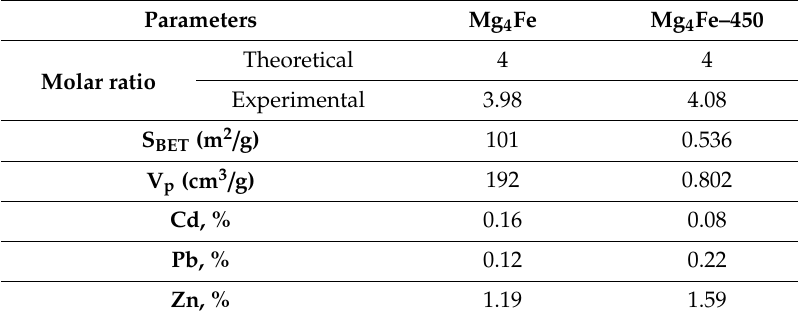
Table 2. Physical and chemical properties of the studied